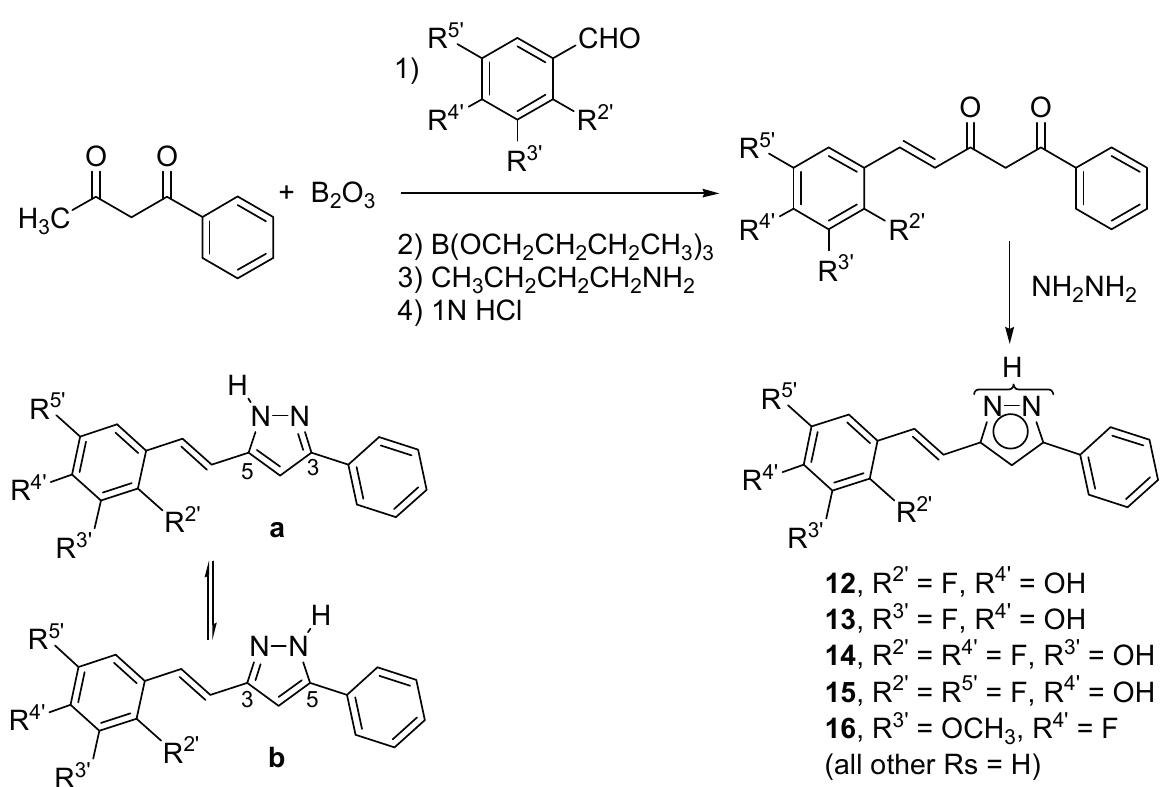
Figure 2. Synthetic scheme used to prepare pyrazoles 12 – 16 , that can exist in two tautomeric forms a and b